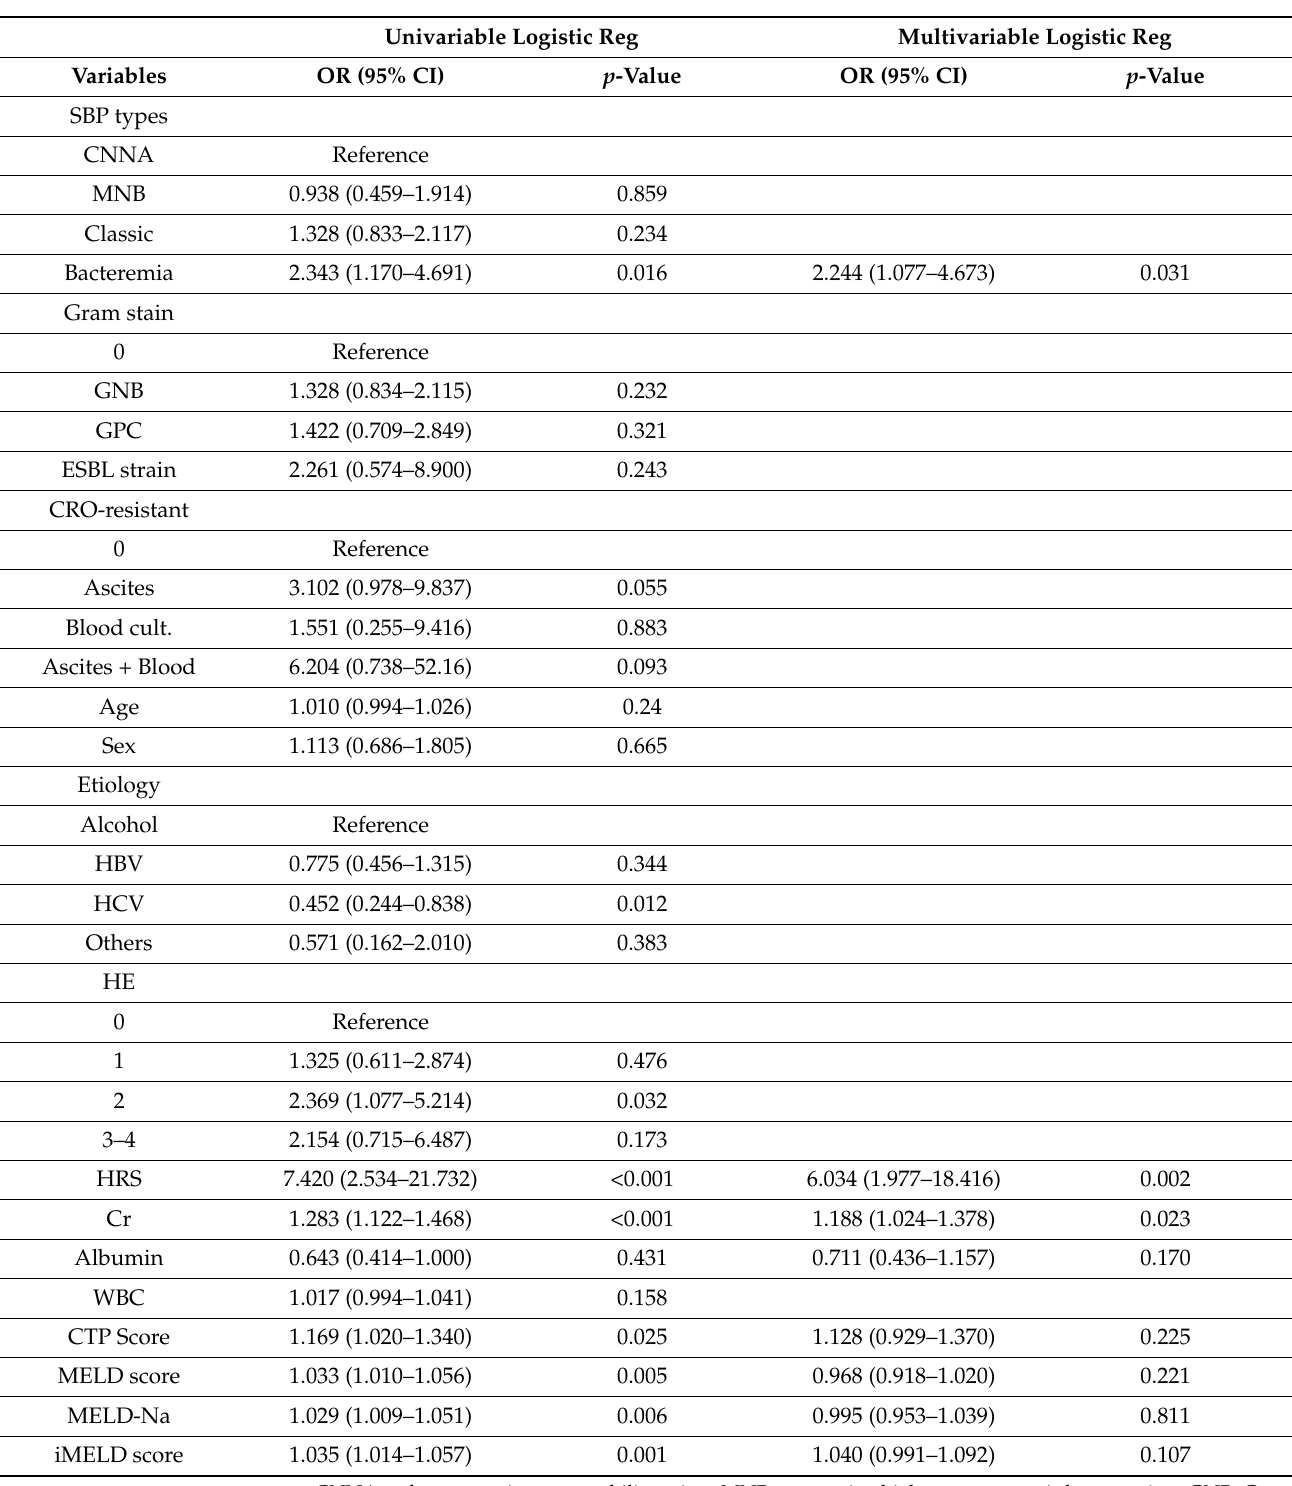
Table 6. Univariable and multivariable logistic regression analysis for predicting 3-month mortality. Univariable Logistic